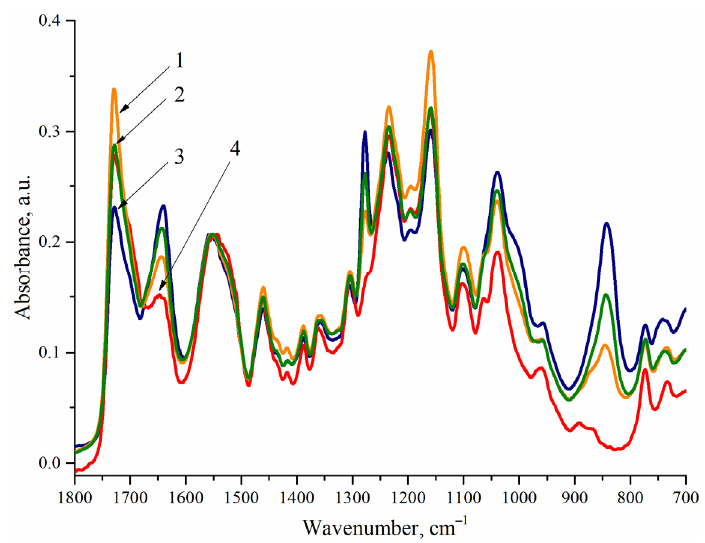
Figure 3. IR spectra for WPU films measured by ATR: 1—sample 1.1; 2—sample 1.2; 3—sample 1.3; 4—sample 2.2.